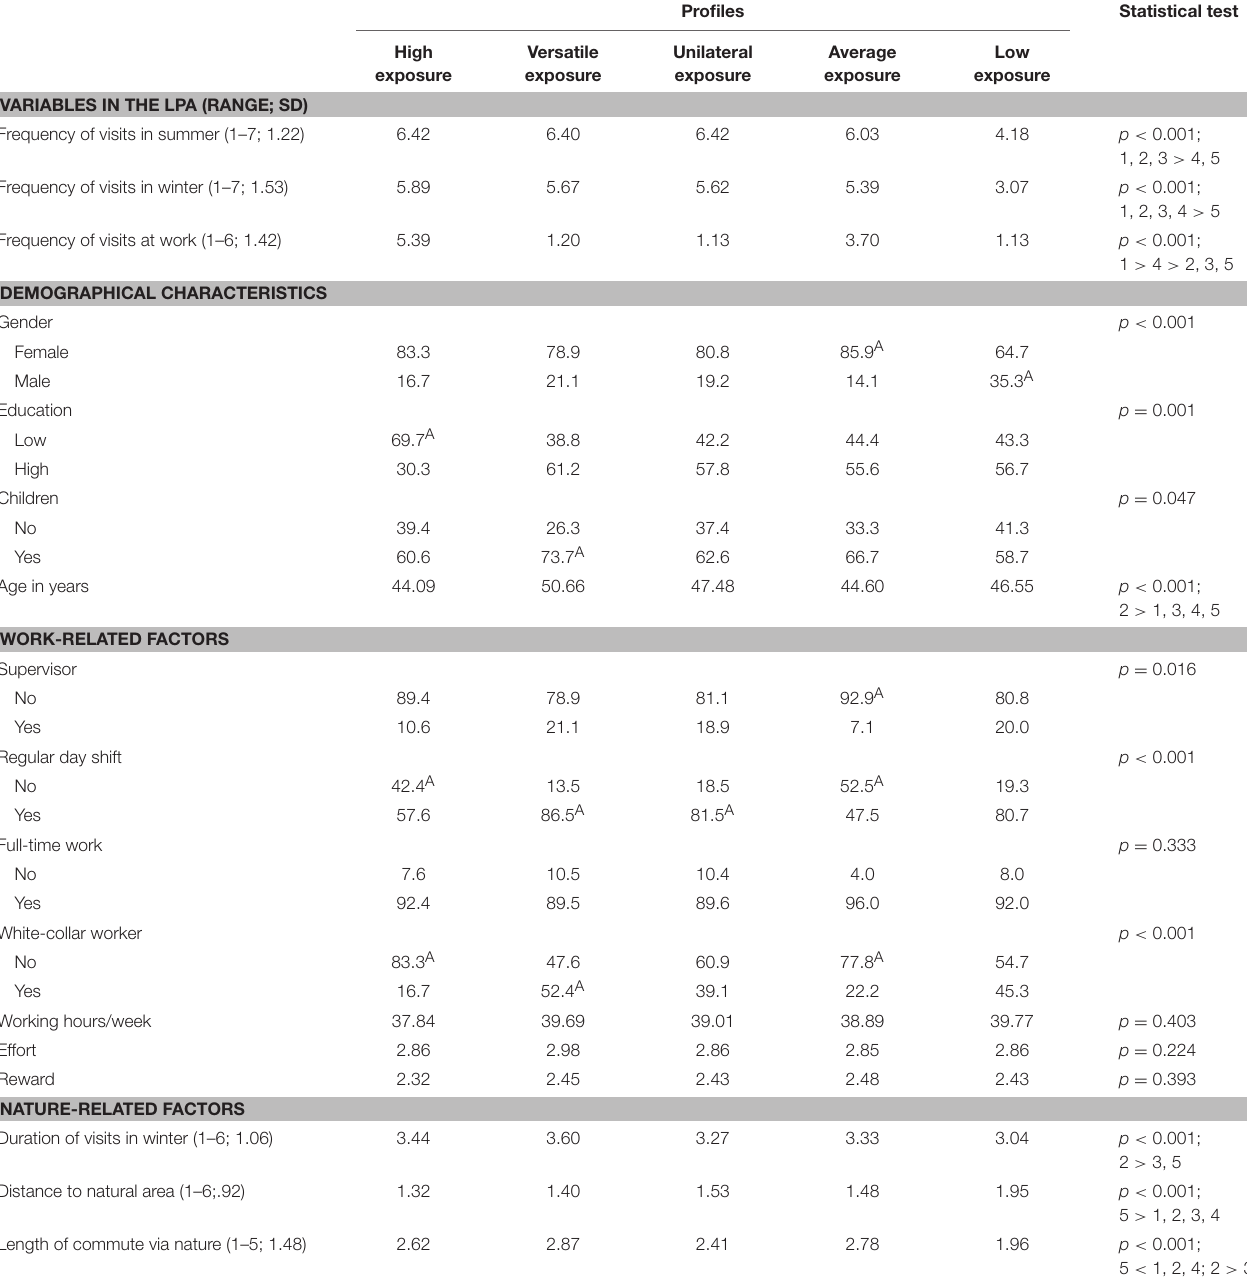
TABLE 4 | Comparison of the profiles: either the percentage or mean is presented with the related statistical testing.